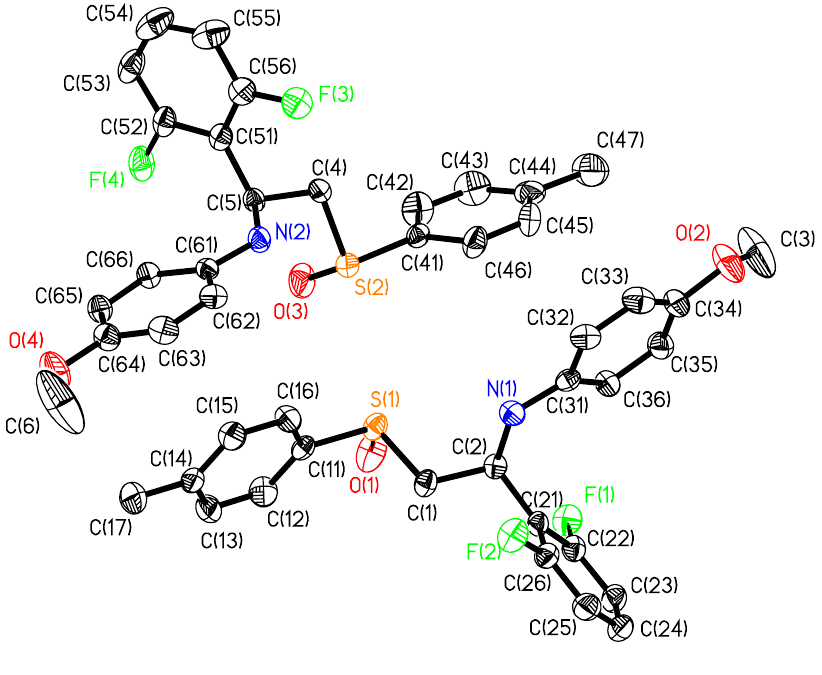
Figure 1 . ORTEP view of (2 S , R )- 3f showing the atomic labeling scheme. Only non hydrogen S atoms are shown, using 30% thermal